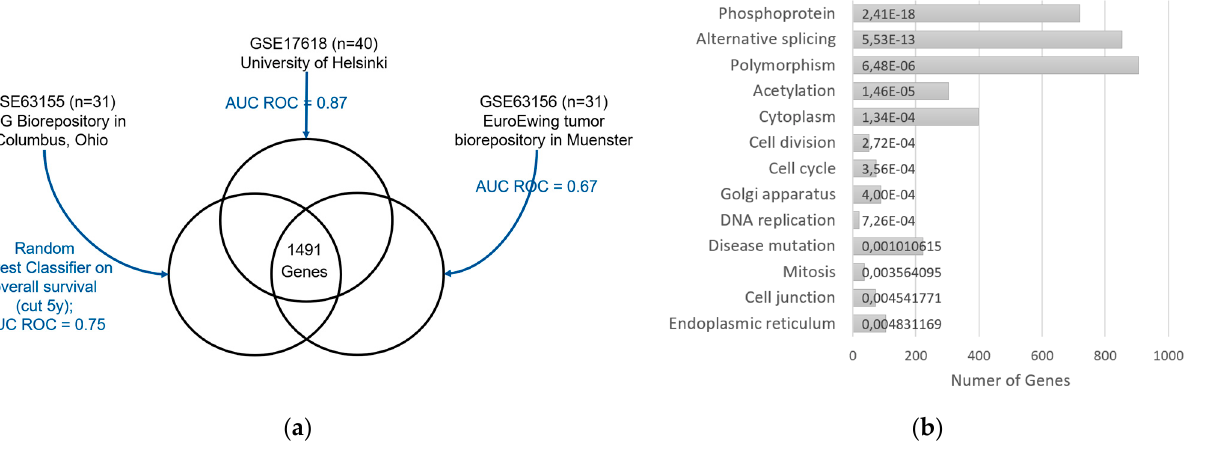
Figure 3. Diagram of machine learning analysis (second filtering step in gene expression analysis) in order to obtain “potential survival genes” in Ewing sarcoma (EwS). ( a ) Random forest classifiers are applied to 3 public datasets (GSE63155, GSE17618, GSE63156) in 10-fold cross-validation, obtaining an area under the receiver operating characteristic curve (ROC AUC) of 0.67 to 0.87. These models yield genes that are predictive for survival for each dataset. The intersection of these 3 gene sets contains 1491 genes, which we consider as “potential survival genes” in EwS. ( b ) DAVID functional annotation of “potential survival genes”. Thirteen terms in category UP-KEYWORDS obtained significant p -values (Benjamini adjusted p < 0.01). For each term, the number of annotated genes among the “potential survival genes” and the adjusted p -value is given.